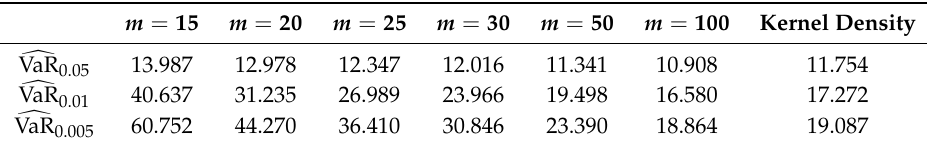
Table 3. VaR estimates for the aggregated risk.